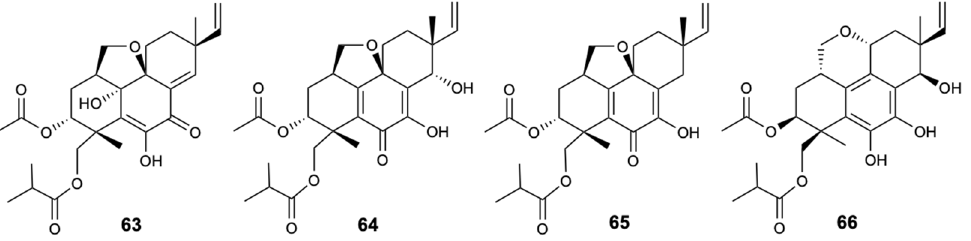
Figure 17. Structures of pimarane diterpenes ( 63 – 66 ).